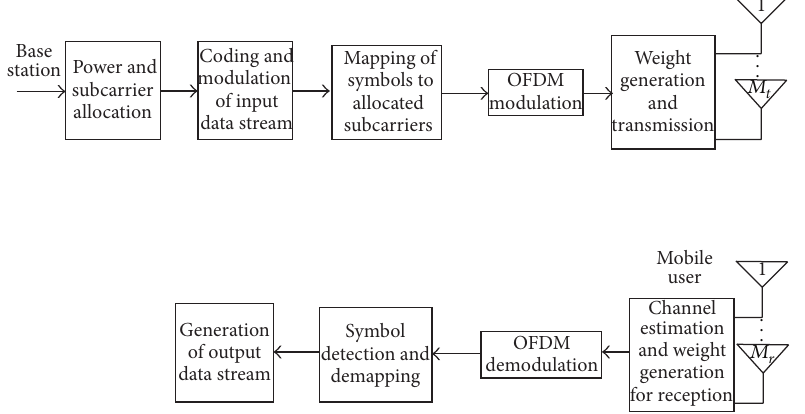
Figure 2: MIMO-OFDMA transceiver general block